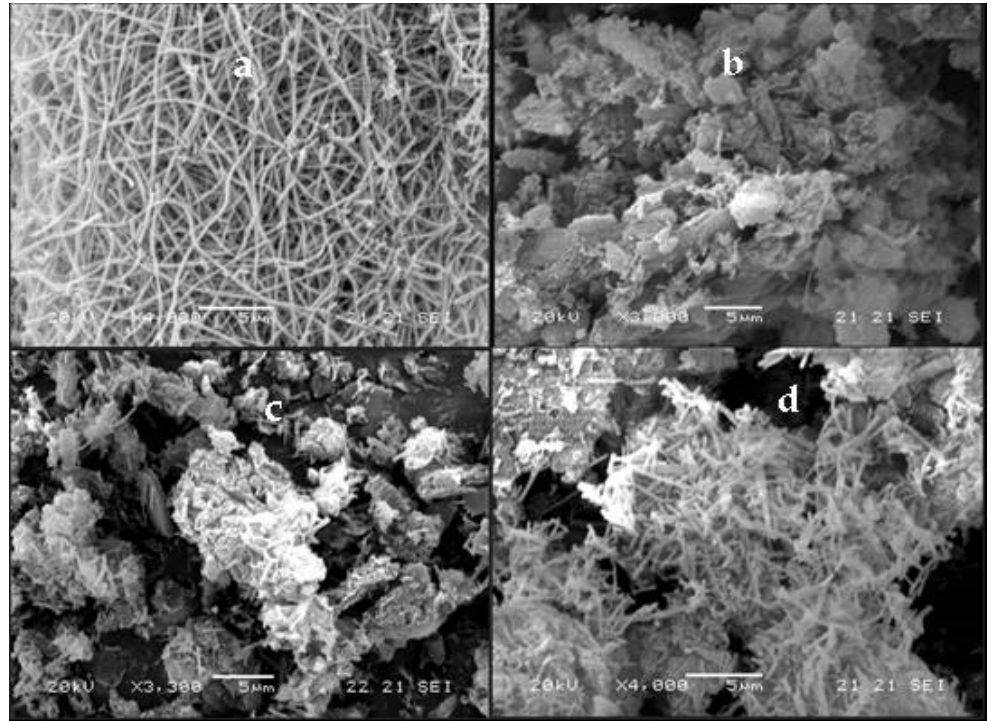
Figure 3. SEM images of electrospun fibers and composite catalysts after calcination ( a ) WO 3 , ( b ) 5%WCN ( c ) 6.5%WCN and ( d ) 10%WCN.